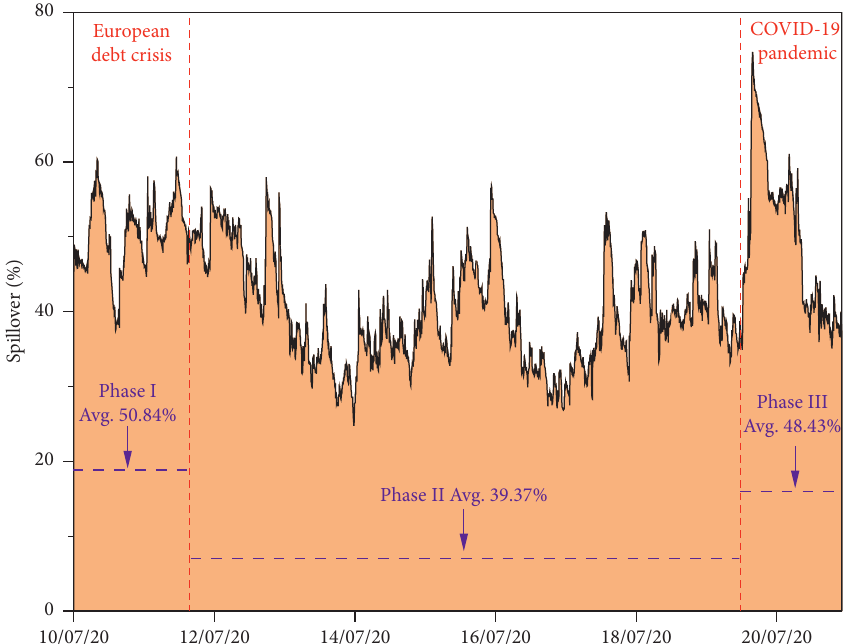
Figure 1: Dynamic return total spillover for TVP-VAR. The orange areas of accumulation define the dynamic return total spillover. The return total spillover plotted here is computed by equation (9). All abbreviations are as follows: bitcoin, gold, and commodities indices (commodities); the world stock index (world); the developed stock index (developed); and the emerging stock index (emerging). The sample period for returns is from July 20, 2020, to June 23,